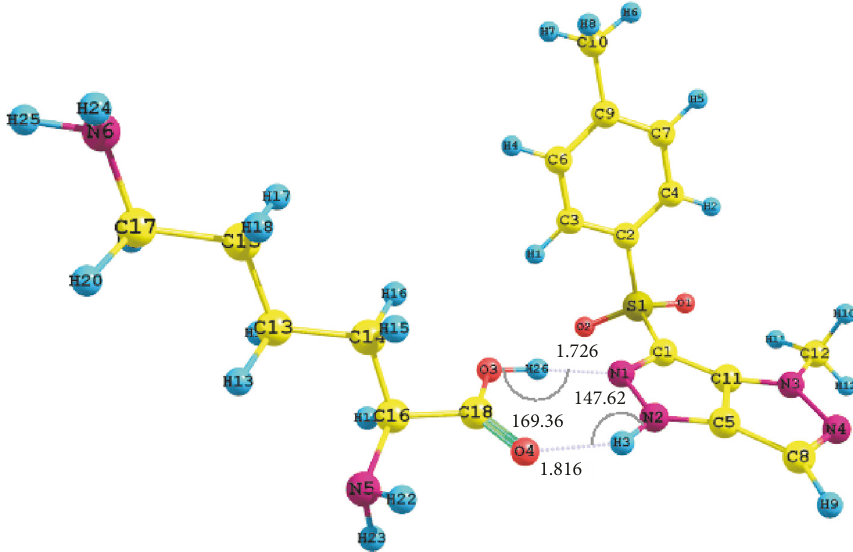
Figure 2: The optimized 7 –lysine adduct 7LysP (PBE0/6-31G(d,p)).